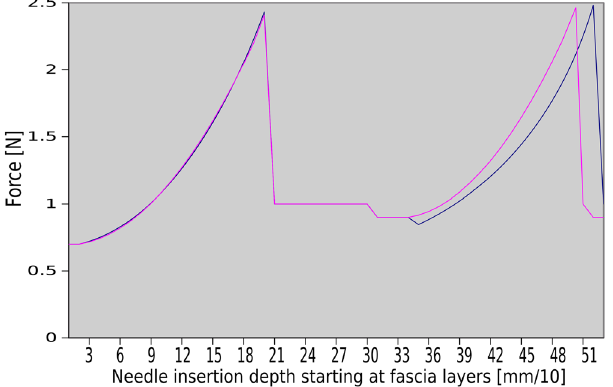
Figure 16. Illustrative sequence of two phase cycles from a phantom experiment with two fascial layers: Force output on the surface of organs depending on slightly different reference and segmentation (left, success mode; right, failure